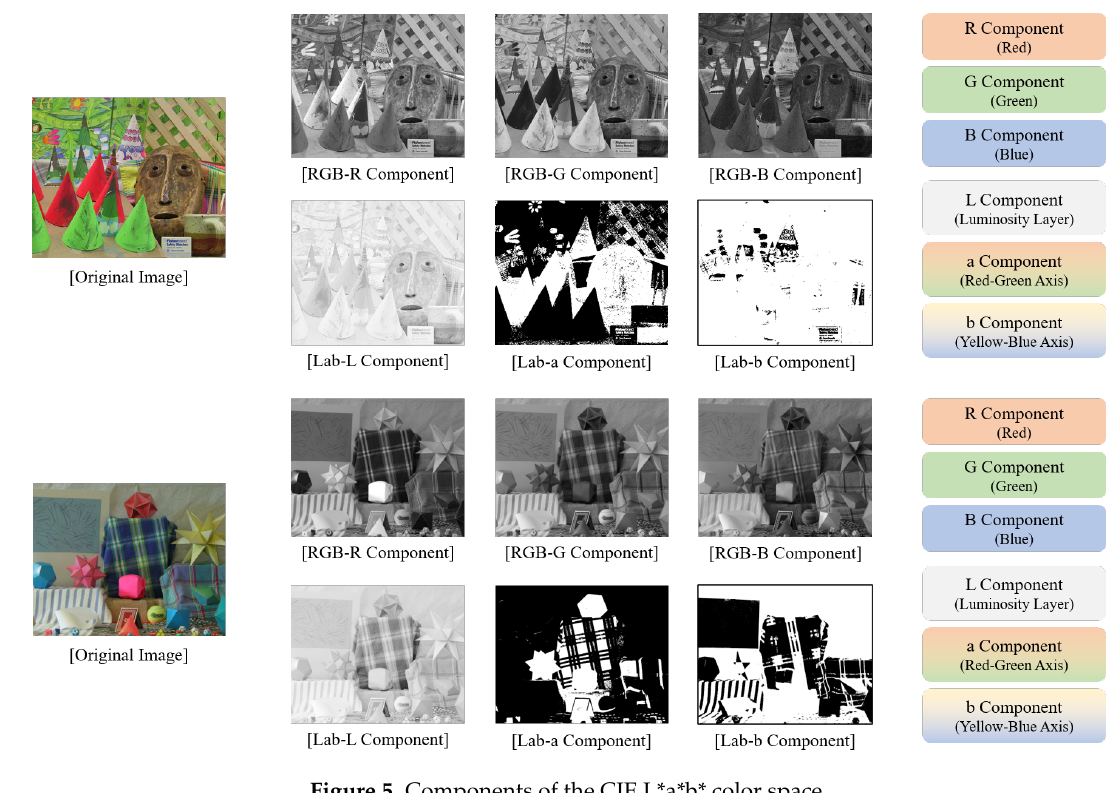
Figure 5. Components of the CIE L*a*b* color space.